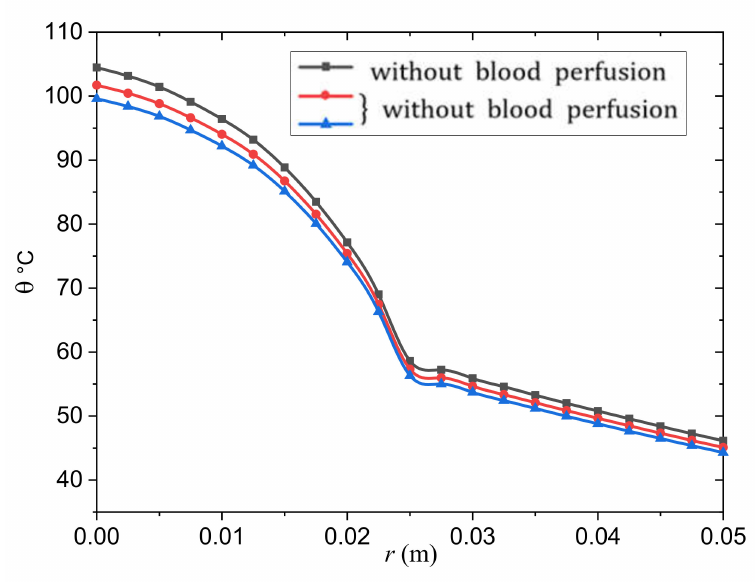
Figure 2. Effect of the blood perfusion W b change on the temperature change in the tumor and normal